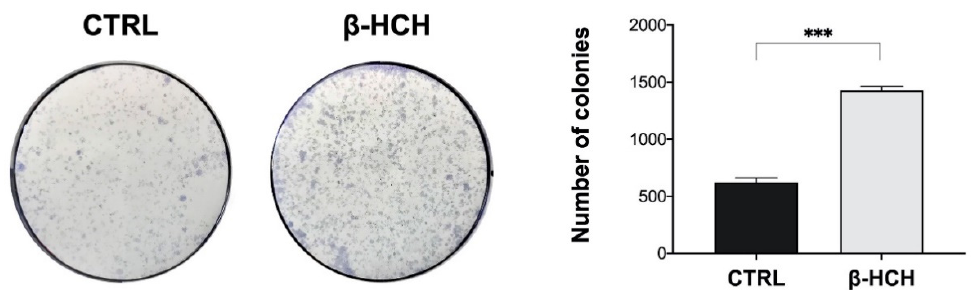
Figure 12. Impact of β -HCH on BEAS-2B cells’ clonogenic potential. Cells were seeded at a density of 200 cells/mL in